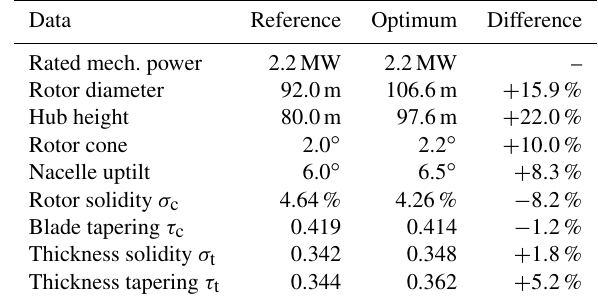
Table 4. Summary of the material properties used in the blades of the 2.2MW wind turbine.